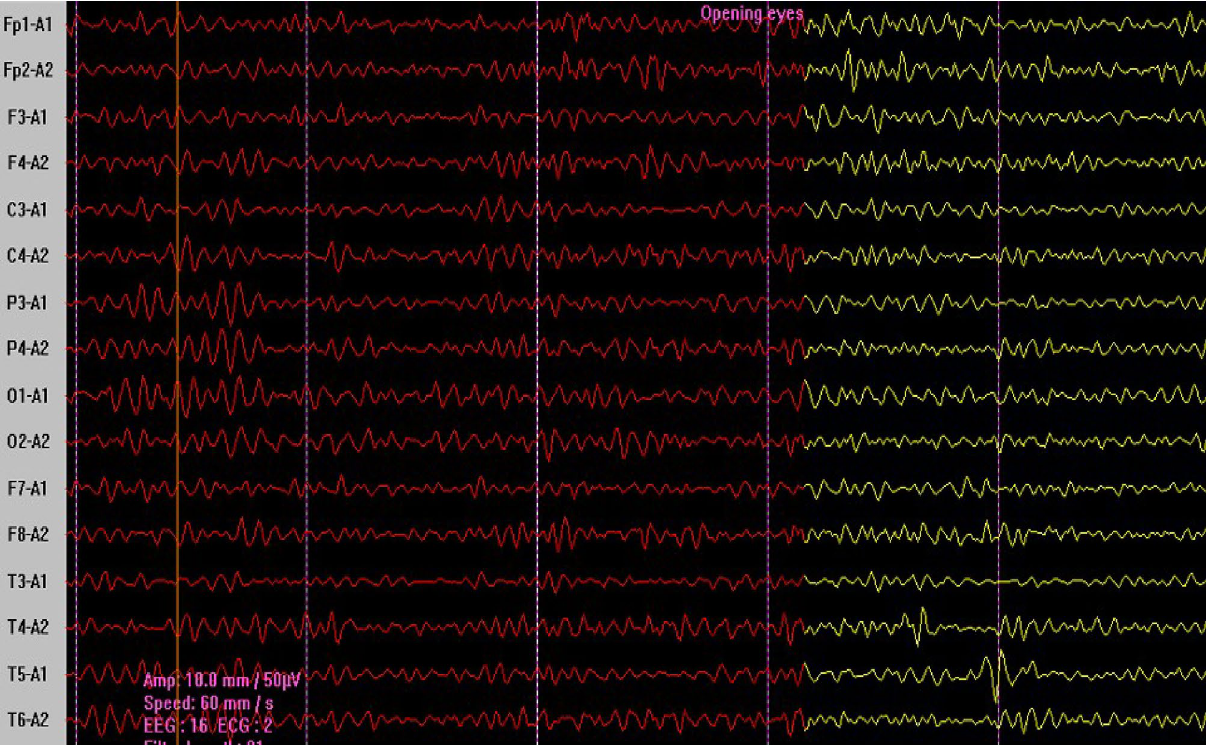
Figure 2. Normal EEG wave pattern. Normal alpha rhythm dominant at O1-A1 and O2-A2 posterior electrodes showing attenuation on eye opening in a pediatric subject. The waves recording show 10–11 ripples (Hz), implying brain cortical waves in alpha bad frequency. Amplitude suppression (yellow) after the opening of eye evidences reactivity that implies normal alpha waves. The posterior dominance is marked by prominent wave amplitude in the posterior electrodes (O1 and